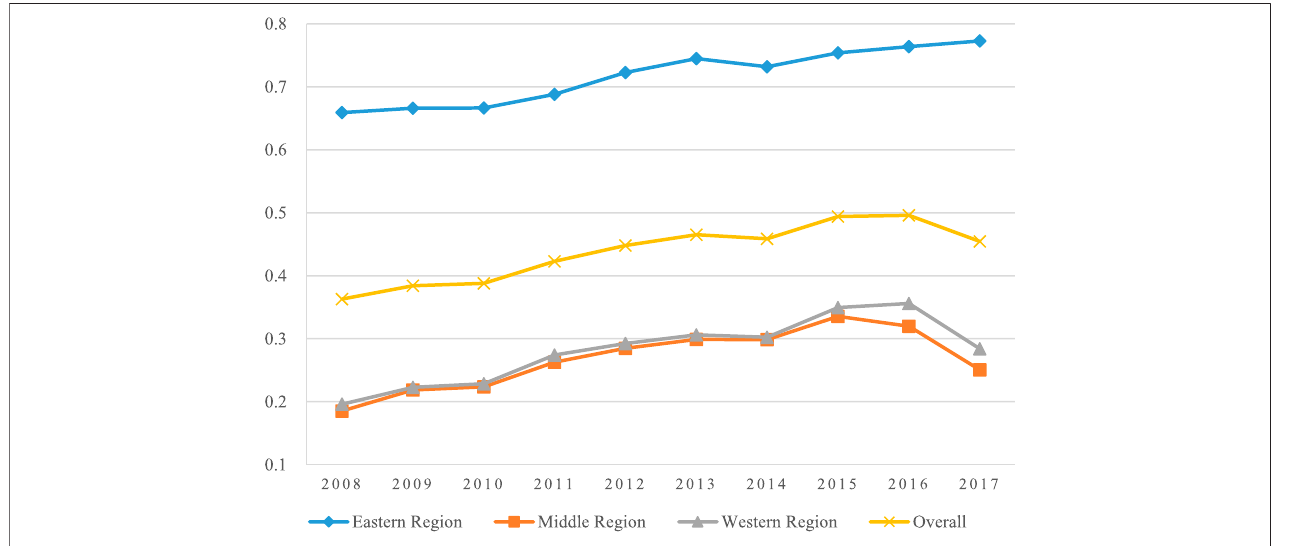
FIGURE 3 | The development trend of environmental ef fi ciency in China ’ s three regions.